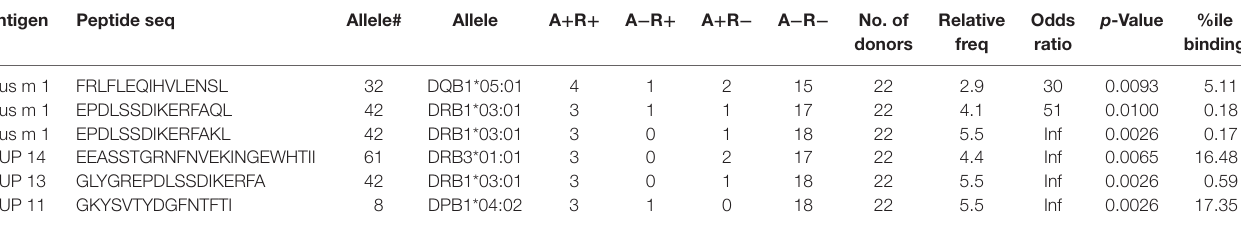
Table 2 | Inferred HLA allele restriction analysis performed using the RATE analysis tool.